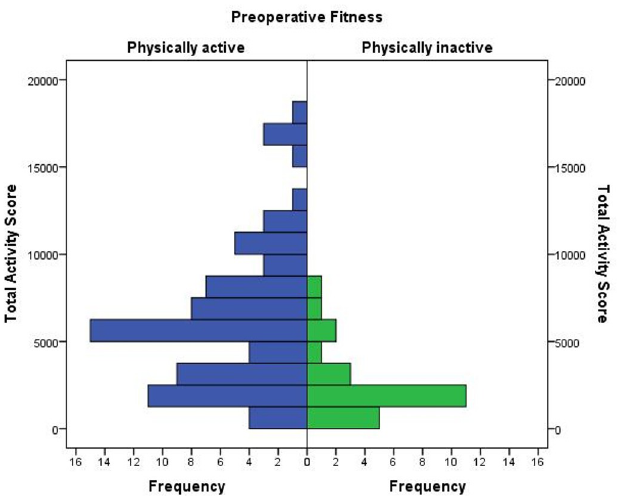
Fig 3. Physical activity and total activity scores. A mirrored bar chart of the various total activity scores for physically active (blue) and inactive (green) patients (n = 100).